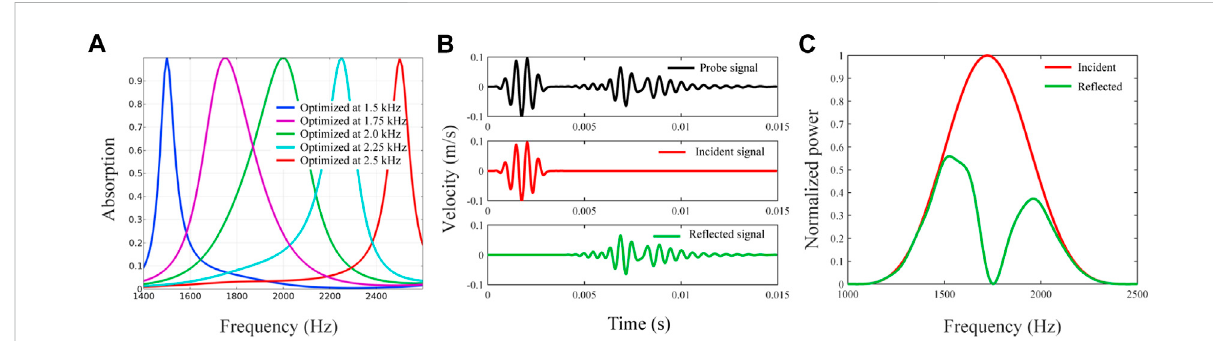
FIGURE 3 Numericalsimulationresultsforthetunableperfect fl exuralwaveabsorber. (A) Illustrationofperfect fl